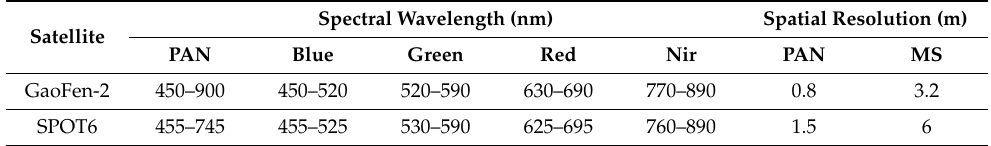
Table 1. Spectral and spatial features of multispectral and panchromatic images from the SPOT6 and GF-2 satellites.